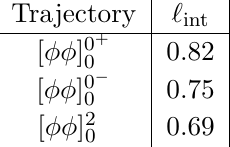
Table 7 . Analytical estimates of the Regge intercepts ‘ int of the leading [ (cid:30)(cid:30) ] 0 (cid:6) ; 2